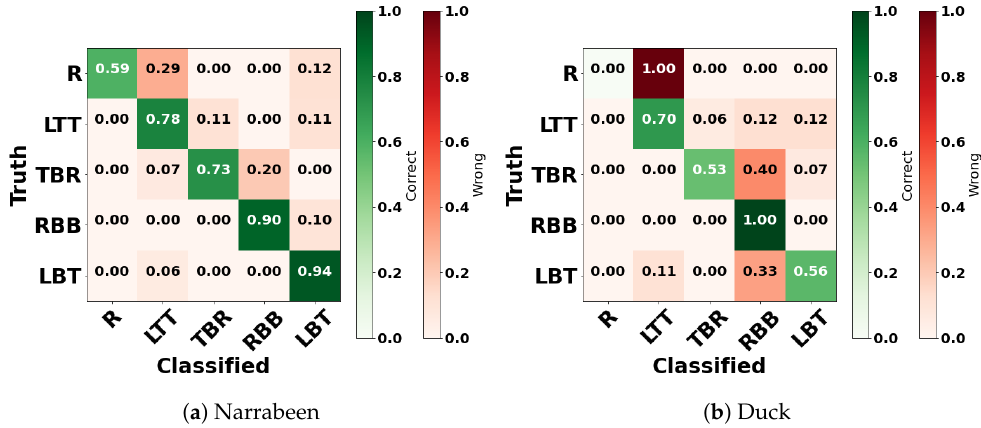
Figure 8. Normalized confusion matrices for the NBN-CNN tests: ( a ) the per-state performance of the self-test and ( b ) the per-state performance of the transfer-test on Duck.